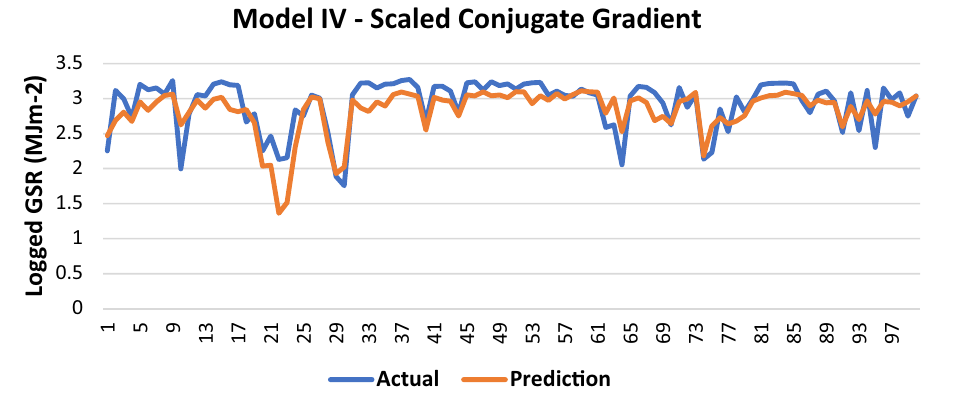
Figure 13. Graph of Actual and Predicted GSR (Model IV—SCG).